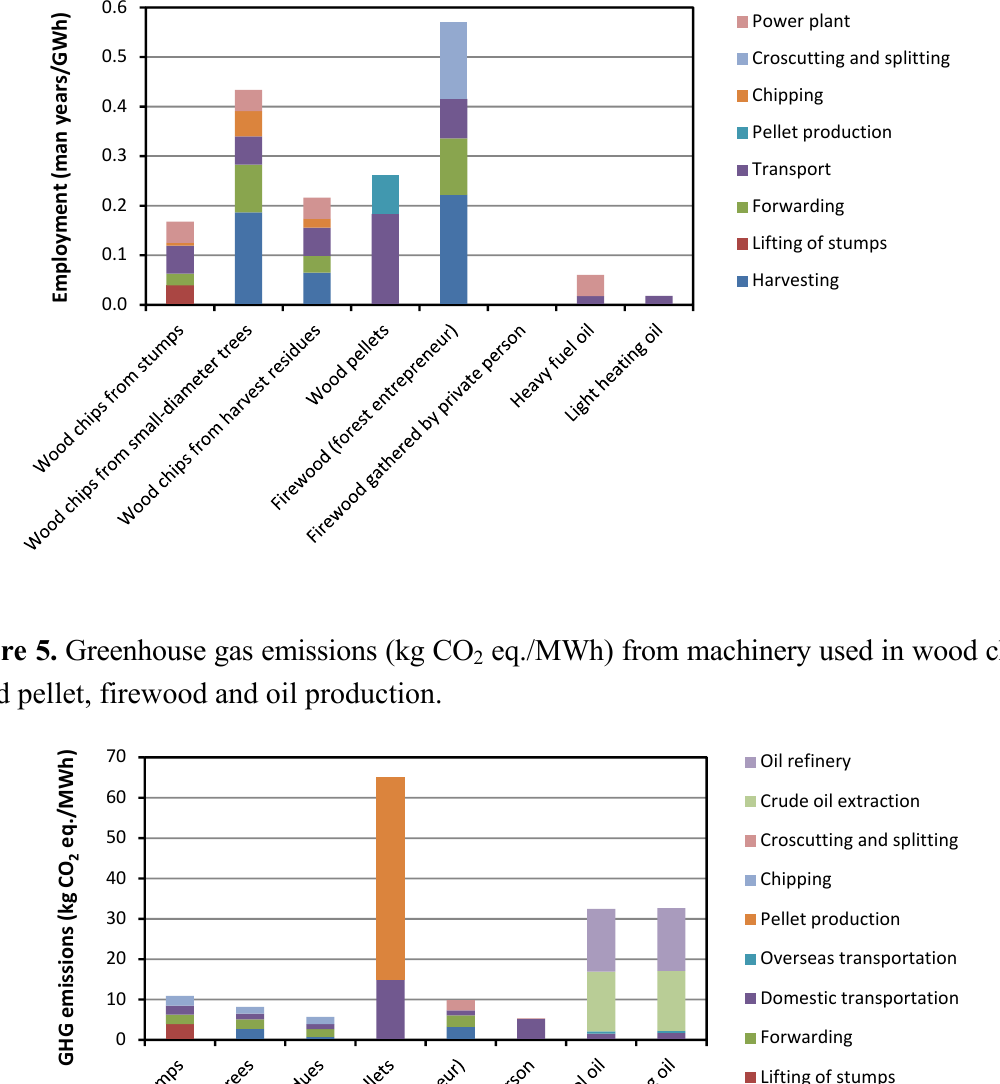
Figure 4. Relative employment (man years/GWh) related to wood chip, wood pellet, firewood and oil production and its use in North Karelia.